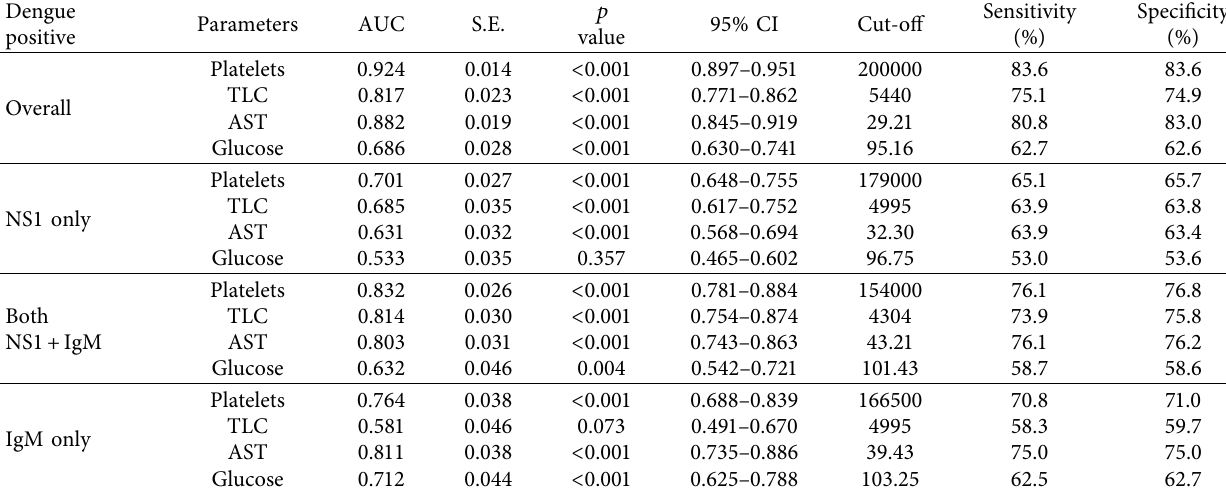
Table 7: AUROC of laboratory parameters in overall positive, NS1 only, NS1 +IgM, and IgM only-positive dengue patients. Dengue